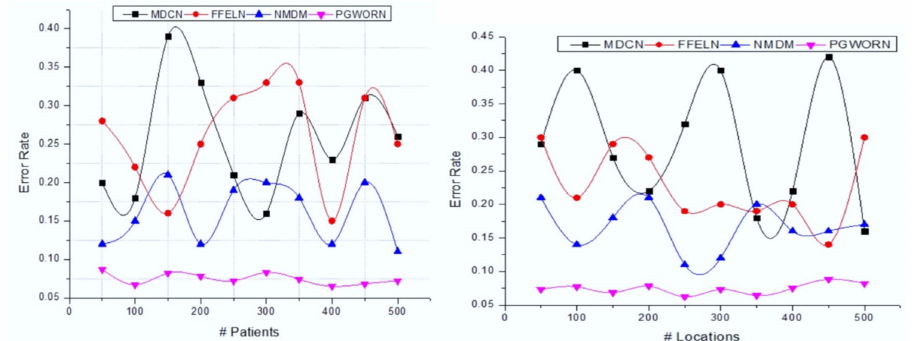
Figure 5. Error-rate analysis with a various number of patients and